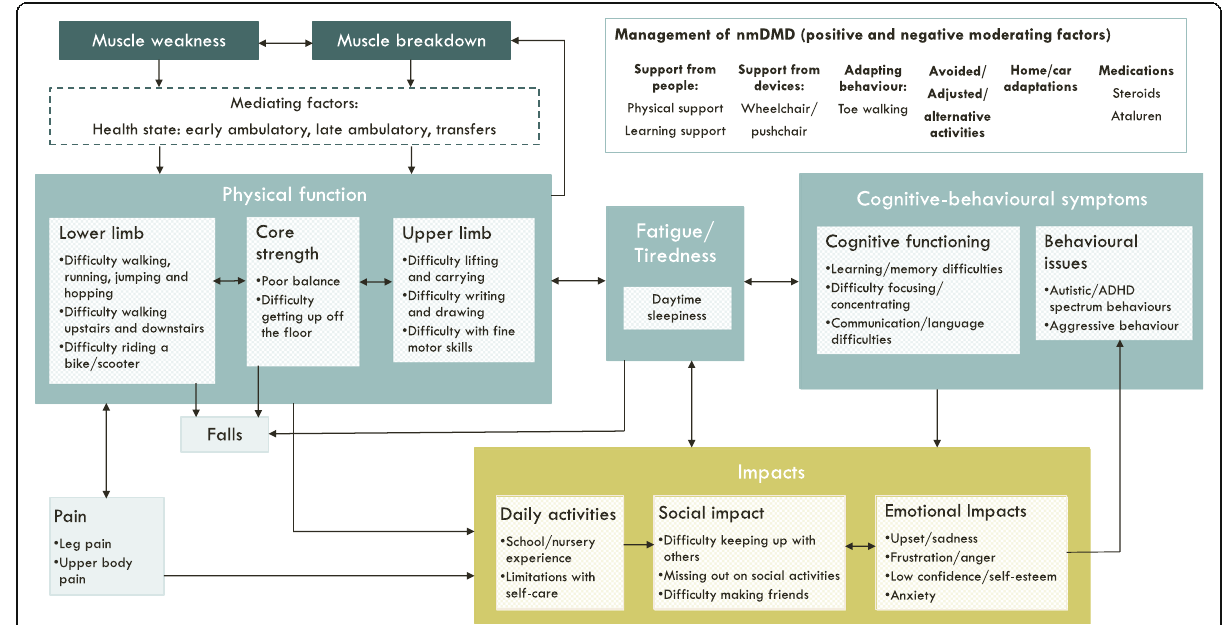
Fig. 1 Conceptual model illustrating the relationships between symptoms and impacts before treatment with